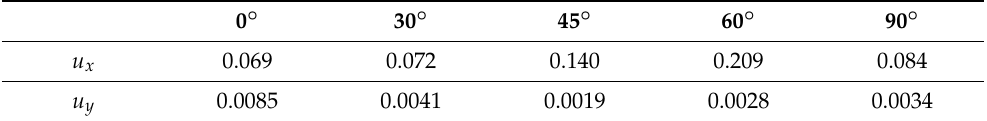
Table A2. Relative errors between predicted mean profiles obtained using Ω deep and Ω complete